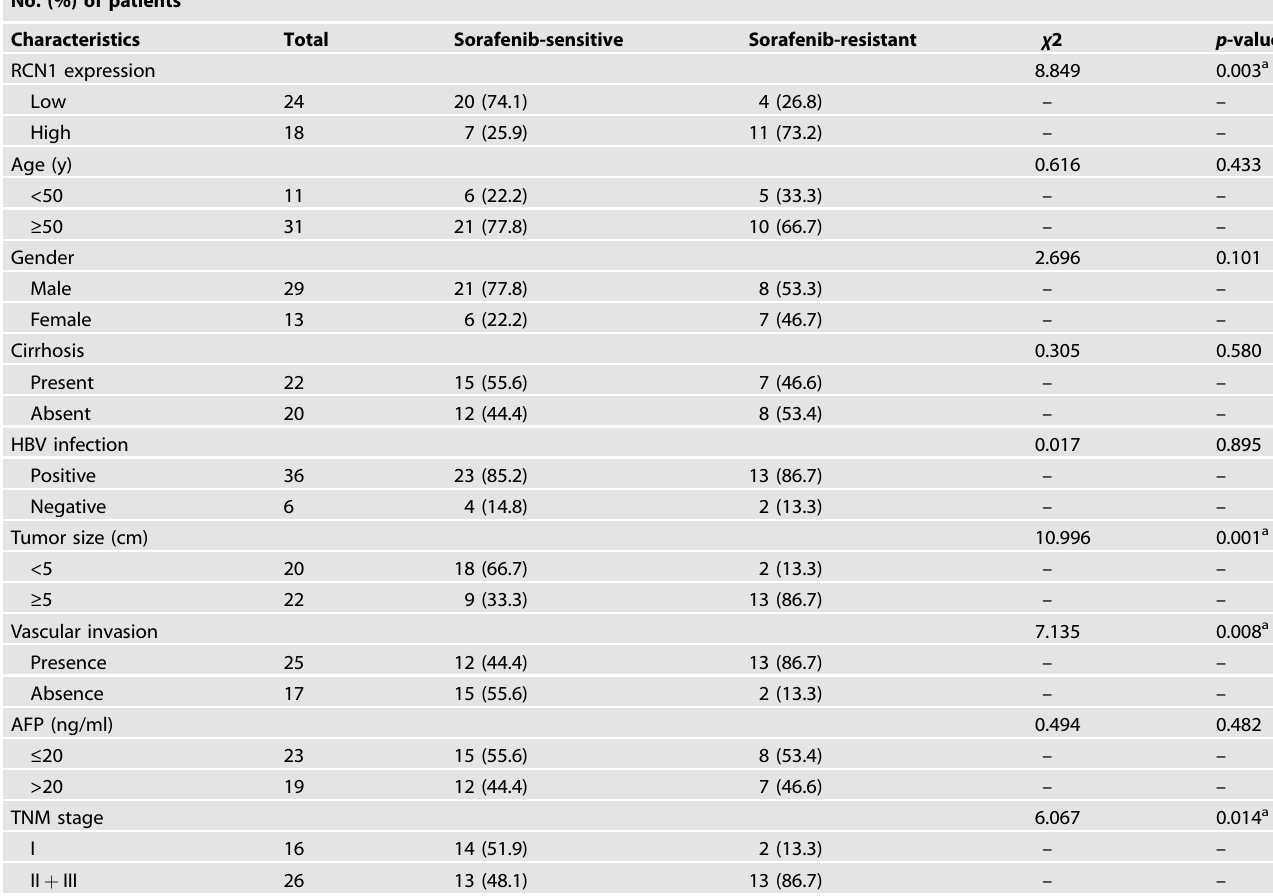
Table 1. Relationship between sorafenib resistance and intratumoral RCN1 expression, clinicopathologic features ( n =